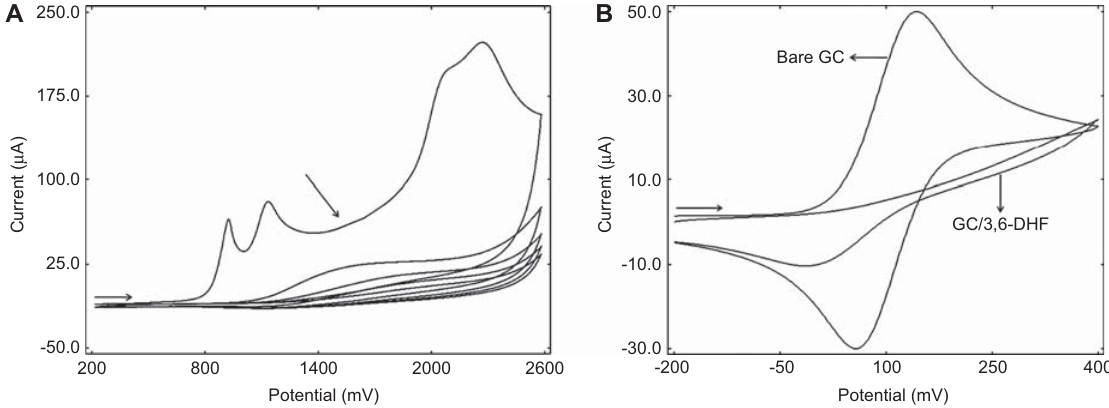
Figure 5 (A) Cyclic voltammogram of 1 m m 3,6-DHF in 0.1 m TBATFB, + 0.2 V and + 2.6 V potential range using 100 mV s -1 with fi ve cycles; (B) surface characterization with ferrocene.